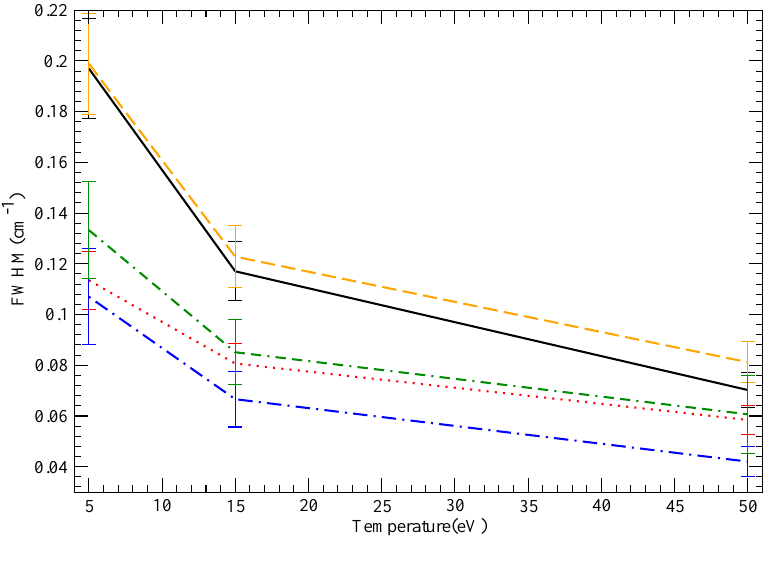
Figure 5. A comparison of hyperbolic and straight line trajectories for the NV 2s-2p transition widths, as computed by SCP-hyperbolic (solid black), SCP-straight (dotted red), SimU-hyperbolic (dashed green), SimU-straight (dash-dotted blue) and Simulation (dash-double dotted